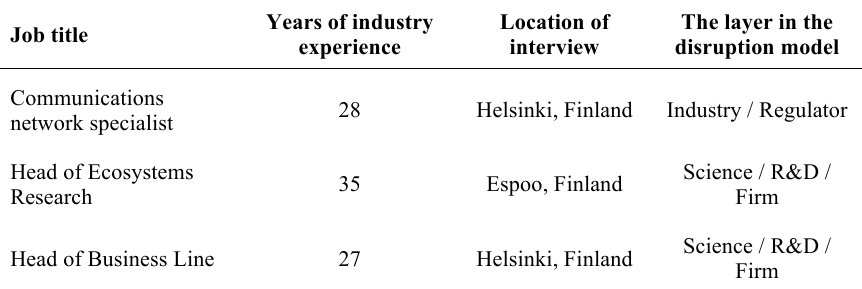
Table 1. Background information of the interviewed